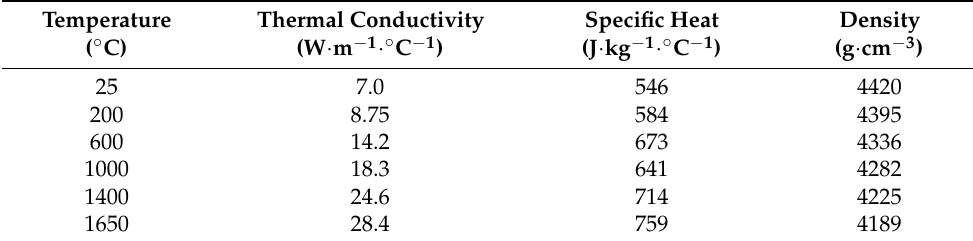
Table 2. Thermal physical parameters of TC4 alloy at different temperatures.